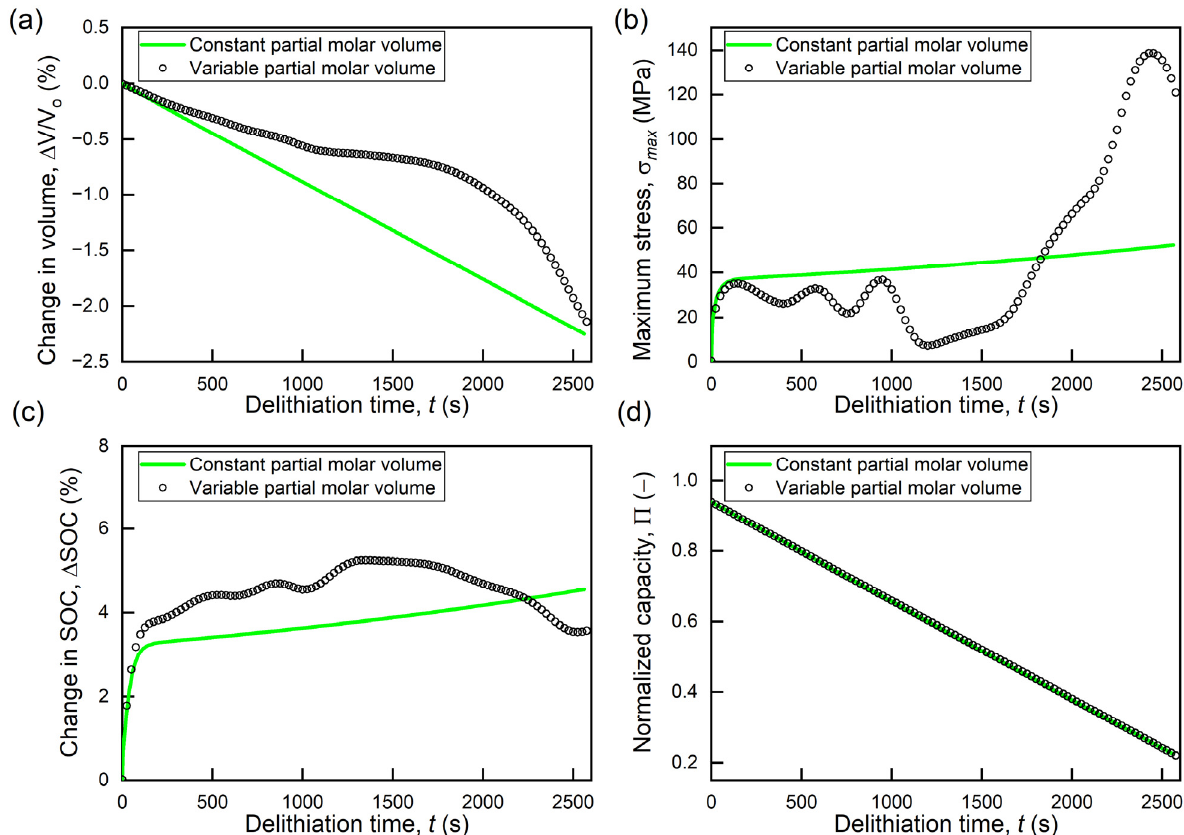
Figure 5. Comparison of the results of the delithiation process simulation with and without considering the concentration-dependent partial molar volume. ( a ) change in the total volume of the active particle ( ∆ V/V o ), ( b ) the maximum value of the local first principal stress ( σ max ), ( c ) the difference between the maximum and minimum local states of charge ( ∆ SOC), and ( d ) the normalized lithium charge capacity ( Π ) inside the active